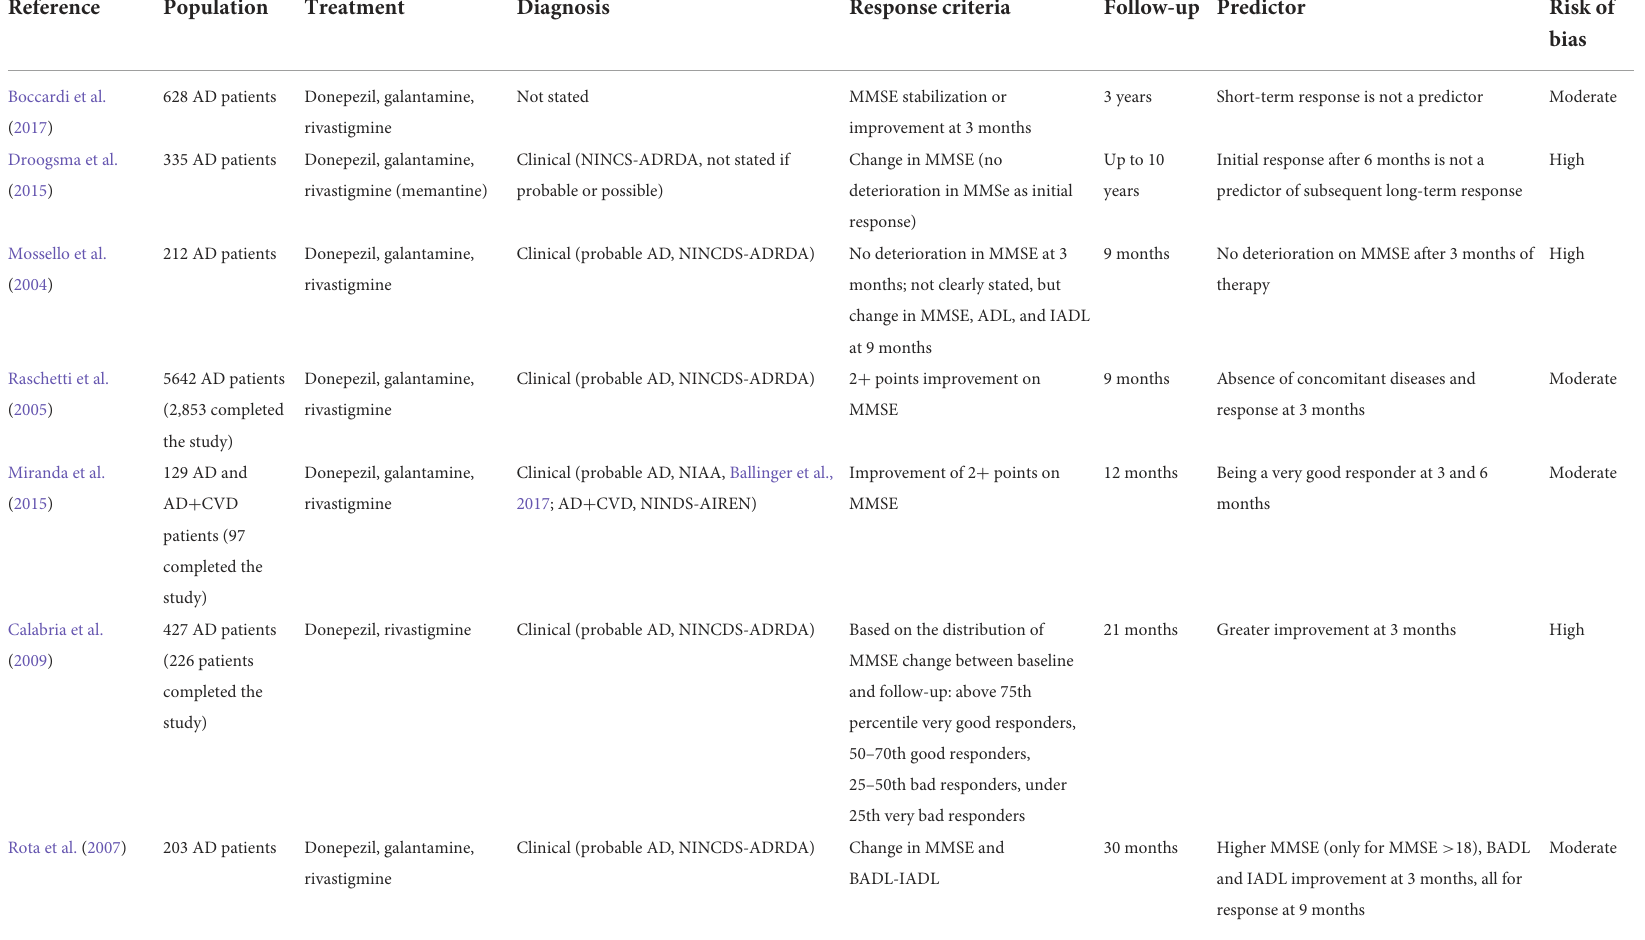
TABLE 7 Short-term